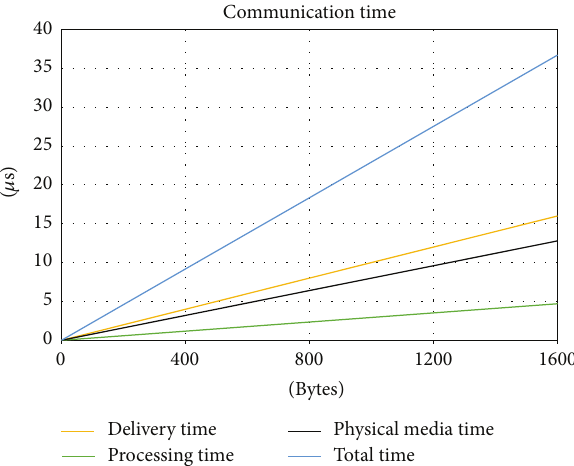
Figure 9: Communication time in each part of the communication